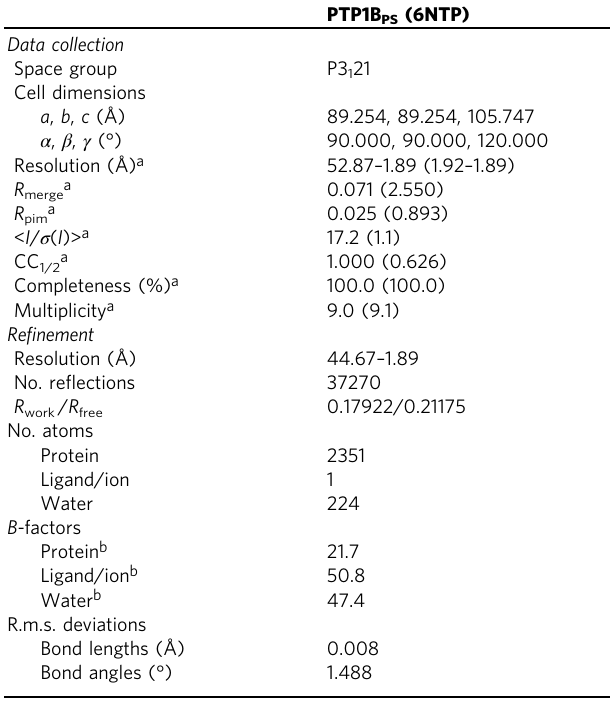
Table 1 Data collection and re fi nement statistics for X-ray crystallographic analysis of PTP1B PS